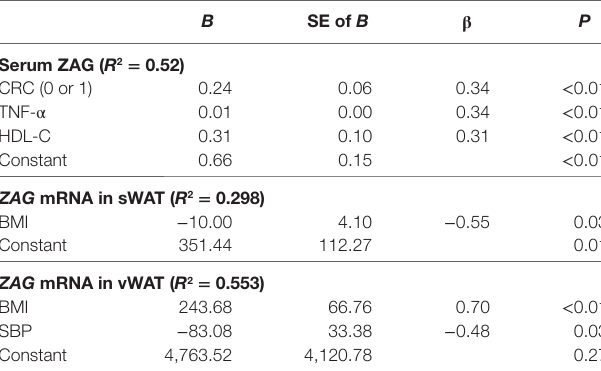
TaBle 3 | Multiple regression analysis for the variables independently related to serum ZAG and ZAG mRNA in sWAT and vWAT in CRC patients. B